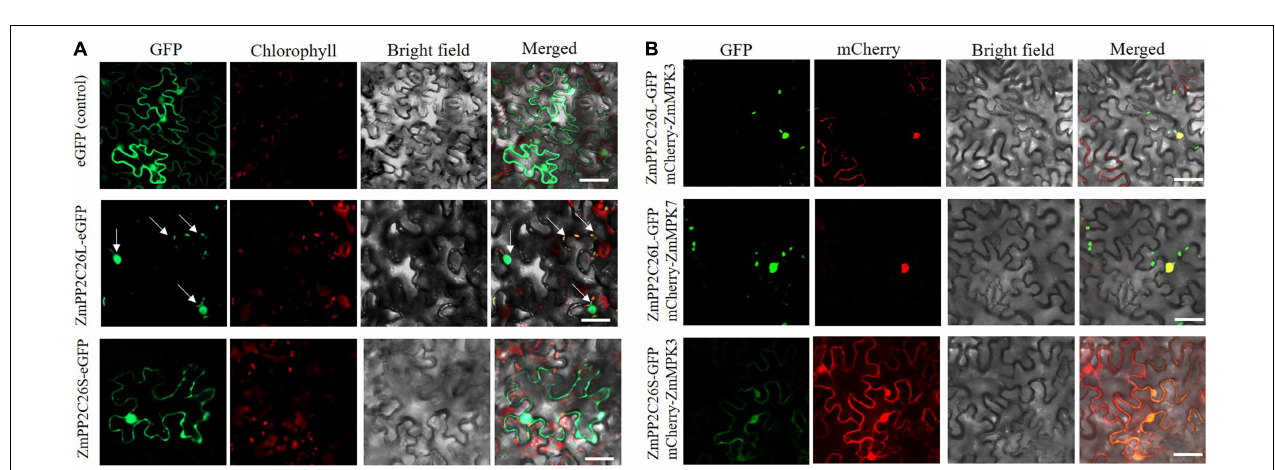
FIGURE 3 | The dephosphorylation assay in vitro . (A) ZmPP2C26L dephosphorylates ZmMAPK3 and ZmMAPK7. (B) ZmPP2C26S dephosphorylates ZmMAPK3. The phospho-ZmMAPK3/-ZmMAPK7 with HA tag was extracted from maize protoplasts, incubated with His-ZmPP2C26L/His-ZmPP2C26S, separated by 12.5% phos-tag SDS-PAGE gel (top panel) or normal SDS-PAGE gel (middle panel), and detected by using an anti-HA or anti-His antibody. Different amounts of His-ZmPP2C26L/His-ZmPP2C26S were used to dephosphorylate ZmMAPK3 and ZmMAPK7. 1 × , 2 × , and 4 × represent 0.25, 0.5, and 1.0 µ g purified His-ZmPP2C26L/-ZmPP2C26S, respectively. + and - denote the presence and absence of the protein in each sample, respectively. The relative intensity of the protein bands was measured using ImageJ, and the lane without His-ZmPP2C26L/His-ZmPP2C26S was set to 1.00.